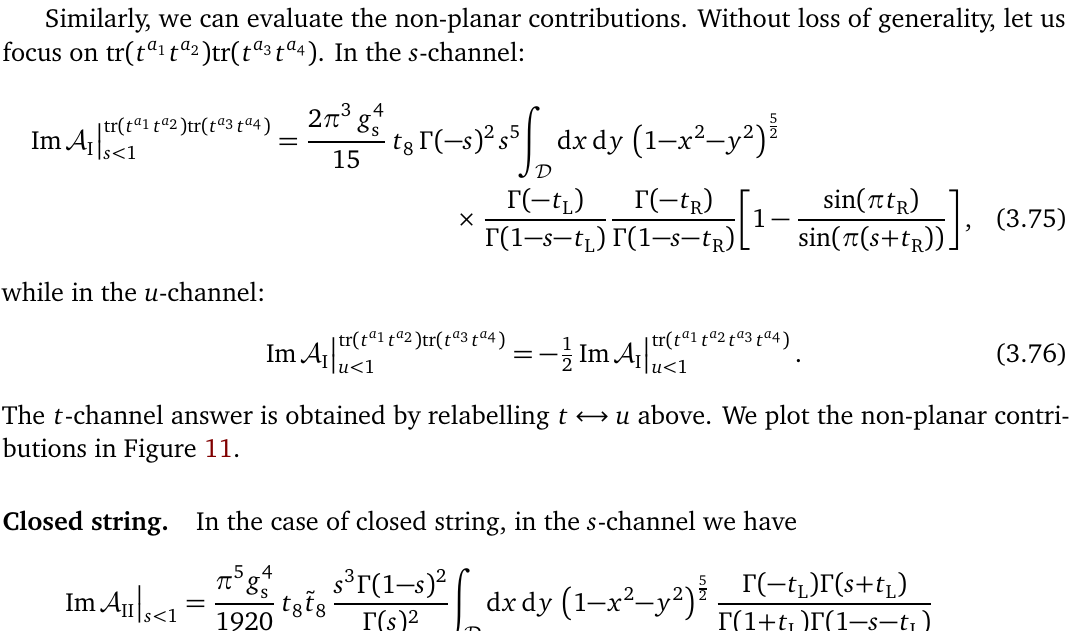
Figure 11: Numerical plot of the non-planar contributions (3.75) and (3.76) to the type I amplitude as in the ( s , t ) -plane obtained by setting g 4 1 ( s − 1 ) 2 in order to remove the double pole at s = 2 9 π 2